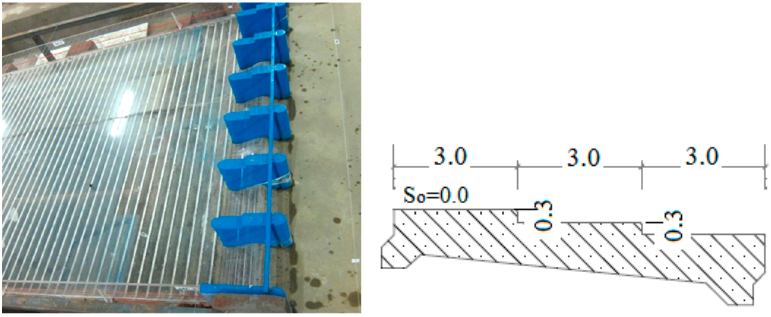
Figure 1. Physical model of Ngan Truoi hydraulic construction [16].